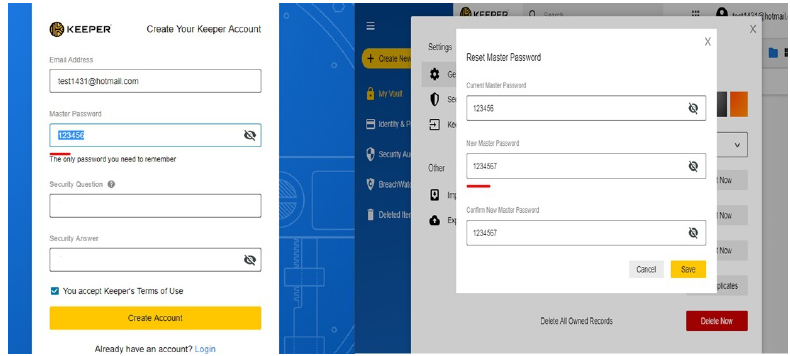
Figure A23. Keeper has a very weak policy for master passwords (the security question and answer are hidden in the left image.)